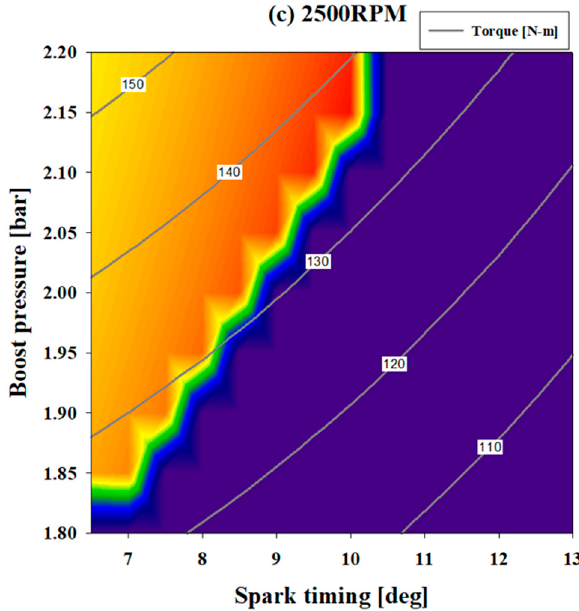
Figure 9. ( a ) Predicting knocking phenomenon according to changes in spark timing and boost pressure at 2500 RPM. ( b ) Predicting NOx amounts according to changes in spark timing and boost pressure at 2500 RPM. ( c ) Predicting torque tendency according to changes in spark timing and boost pressure at 2500 RPM.